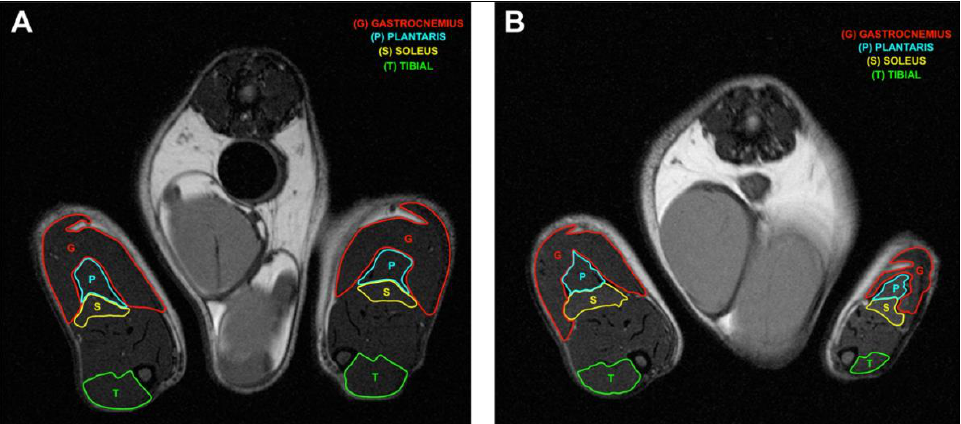
Figure 6. Manual segmentations of individual muscles in axial T2_weighted images with fat suppression of rat hindlimbs. Naïve rat ( A ) and CCI rat ( B ) on day 28.